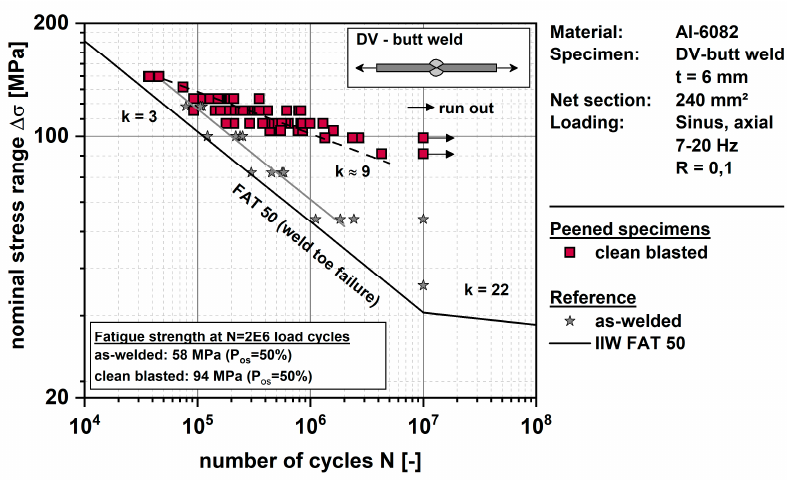
Figure 9. Fatigue test data of clean blasted DV-butt welds made from Al-6082. Shown here are test series 7–8, 12, 13 and 18–20 named as “clean blasted” without further distinction.